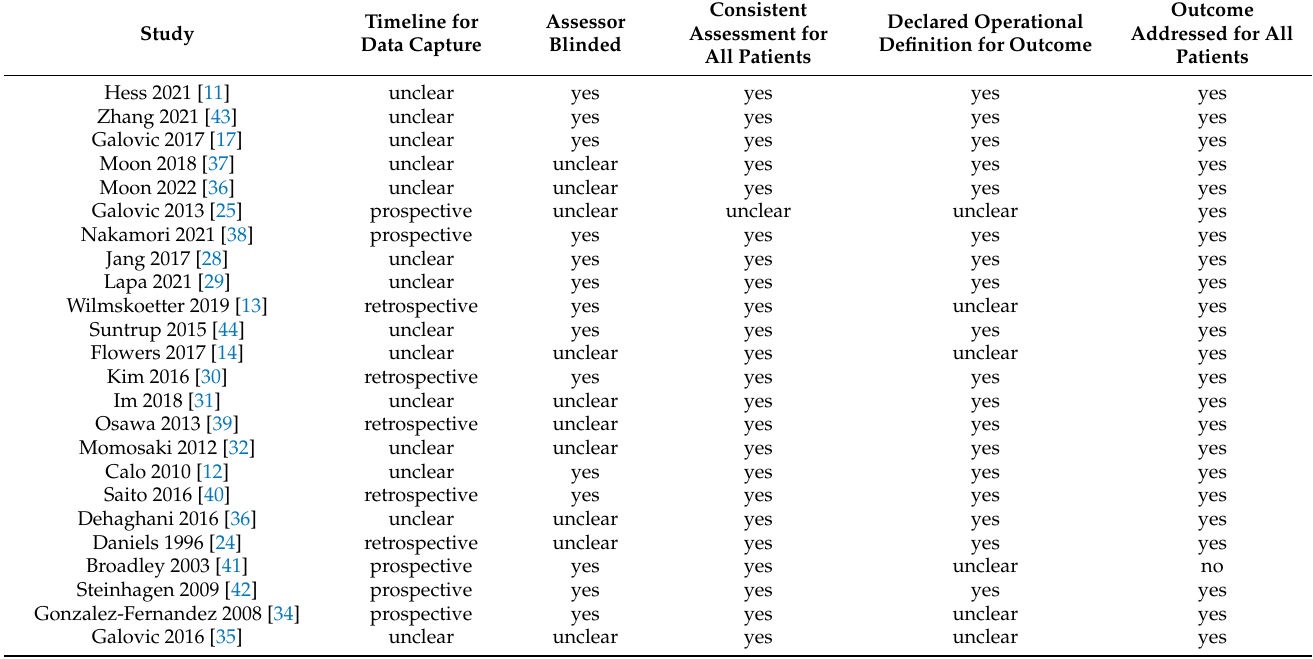
Table 2. Evaluation of study